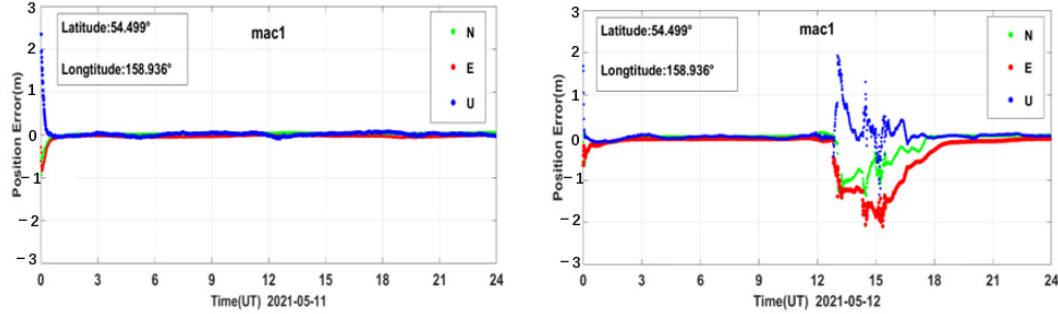
Figure 15. PPP error time series of BDS station mac1 during the reference day and the geomagnetic storm day.